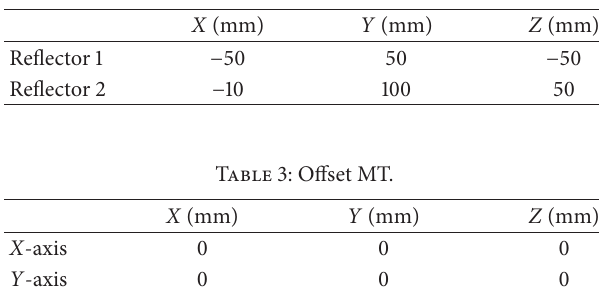
Table 2: Position reflector relative to SC3.